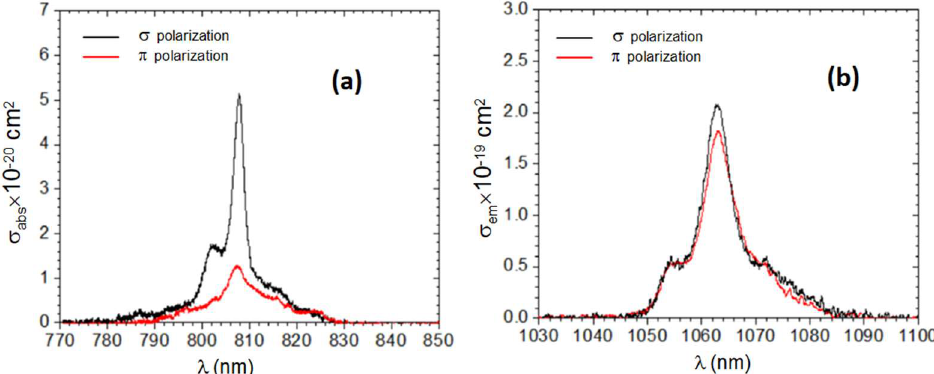
Figure 4. ( a ) Polarization selective absorption cross section of an a -cut Nd:LGSB crystal. ( b ) The emission cross section of Nd:LGSB for the 4 F 3/2 → 4 I 11/2 transition at 1063 nm.